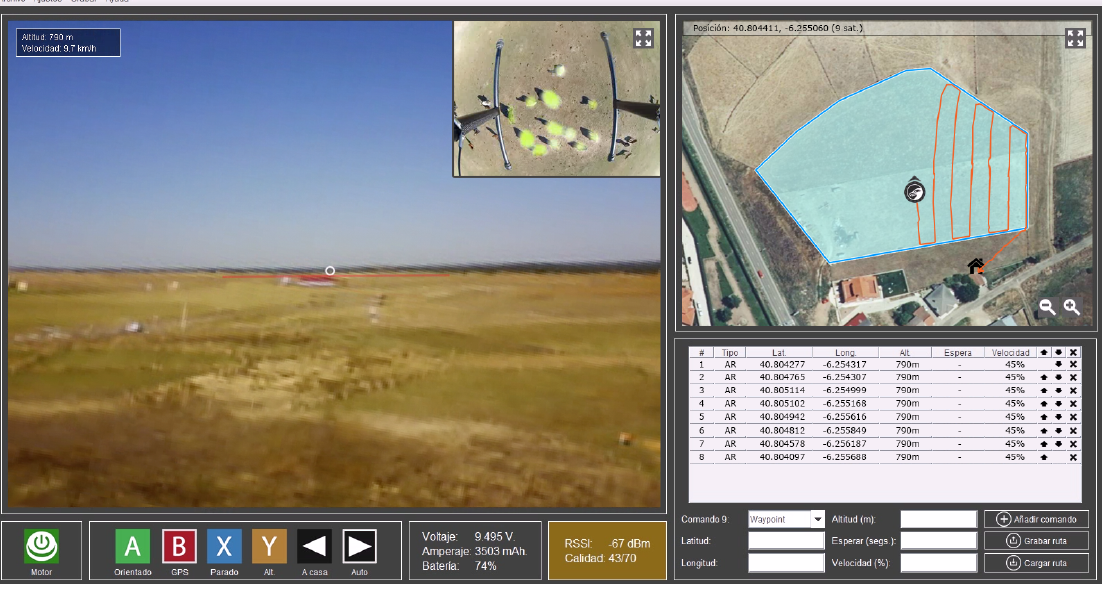
Figure 8. Software developed showing the analyzed